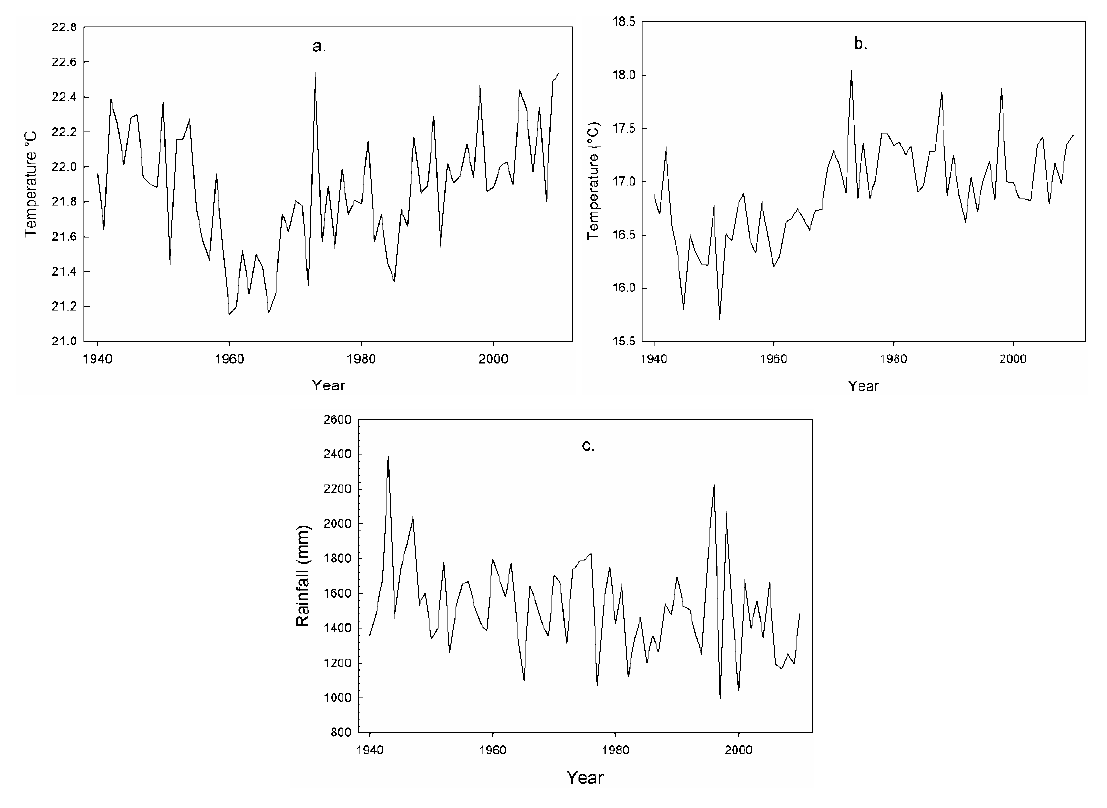
Figure 2. Climate on Lord Howe Island, 1940 (cid:177) 2010. ( a ) Mean annual maximum temperatures. ( b ) Mean annual minimum temperatures. ( c ) Total annual